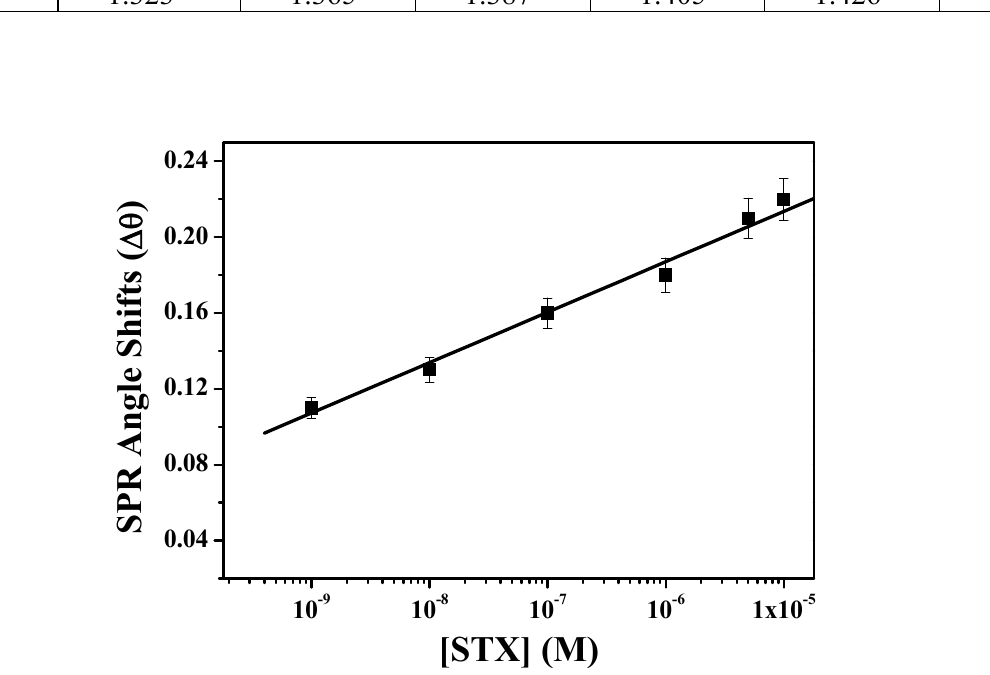
Figure 5. Relative SPR angle shifts of 3 SAM corresponding to various concentration of